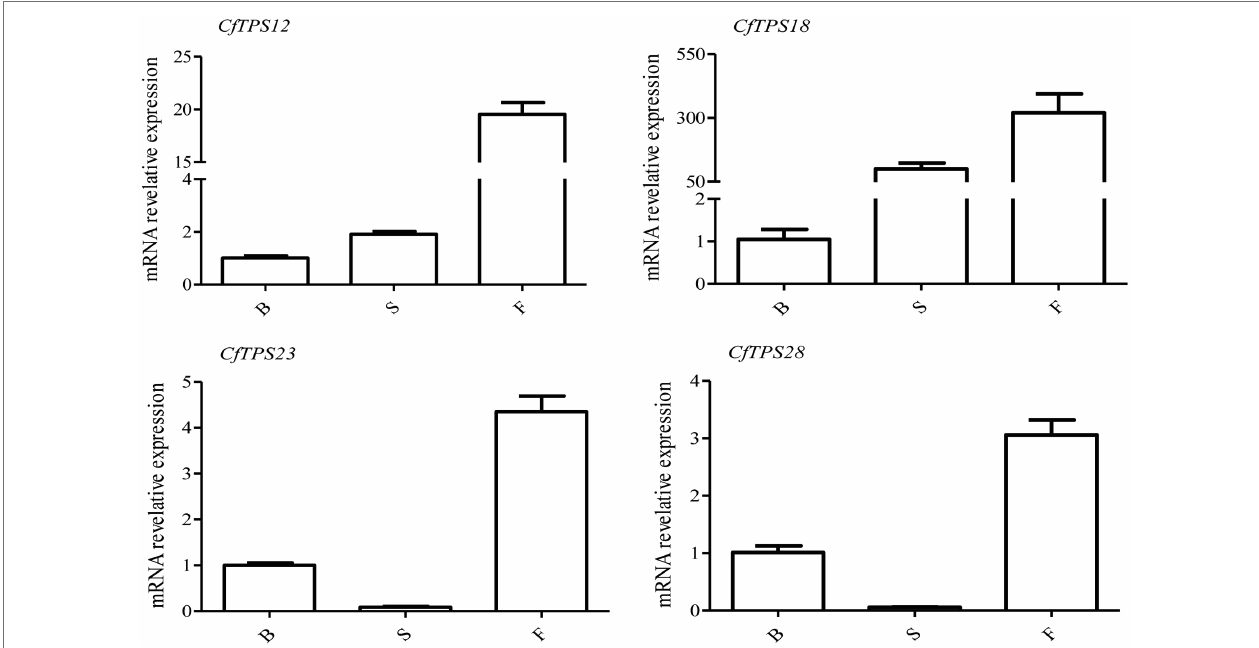
FIGURE 8 | Real-time reverse transcription quantitative PCR (RT-qPCR) validation of transcriptomic data of the CfTPS genes at three flowering stages. B, budding flowers; S, semi-open flowers; and F, fully open flowers. The error bars indicate three RT-qPCR biological replicates. The values were standardized by the C. faberi reference gene GAPDH (GenBank Accession: JX560732; Tian et al., 2020). The expression values of CfTPS genes are listed in Supplementary Table S11 , and the RT-qPCR primers of CfTPS are listed in Supplementary Table S12